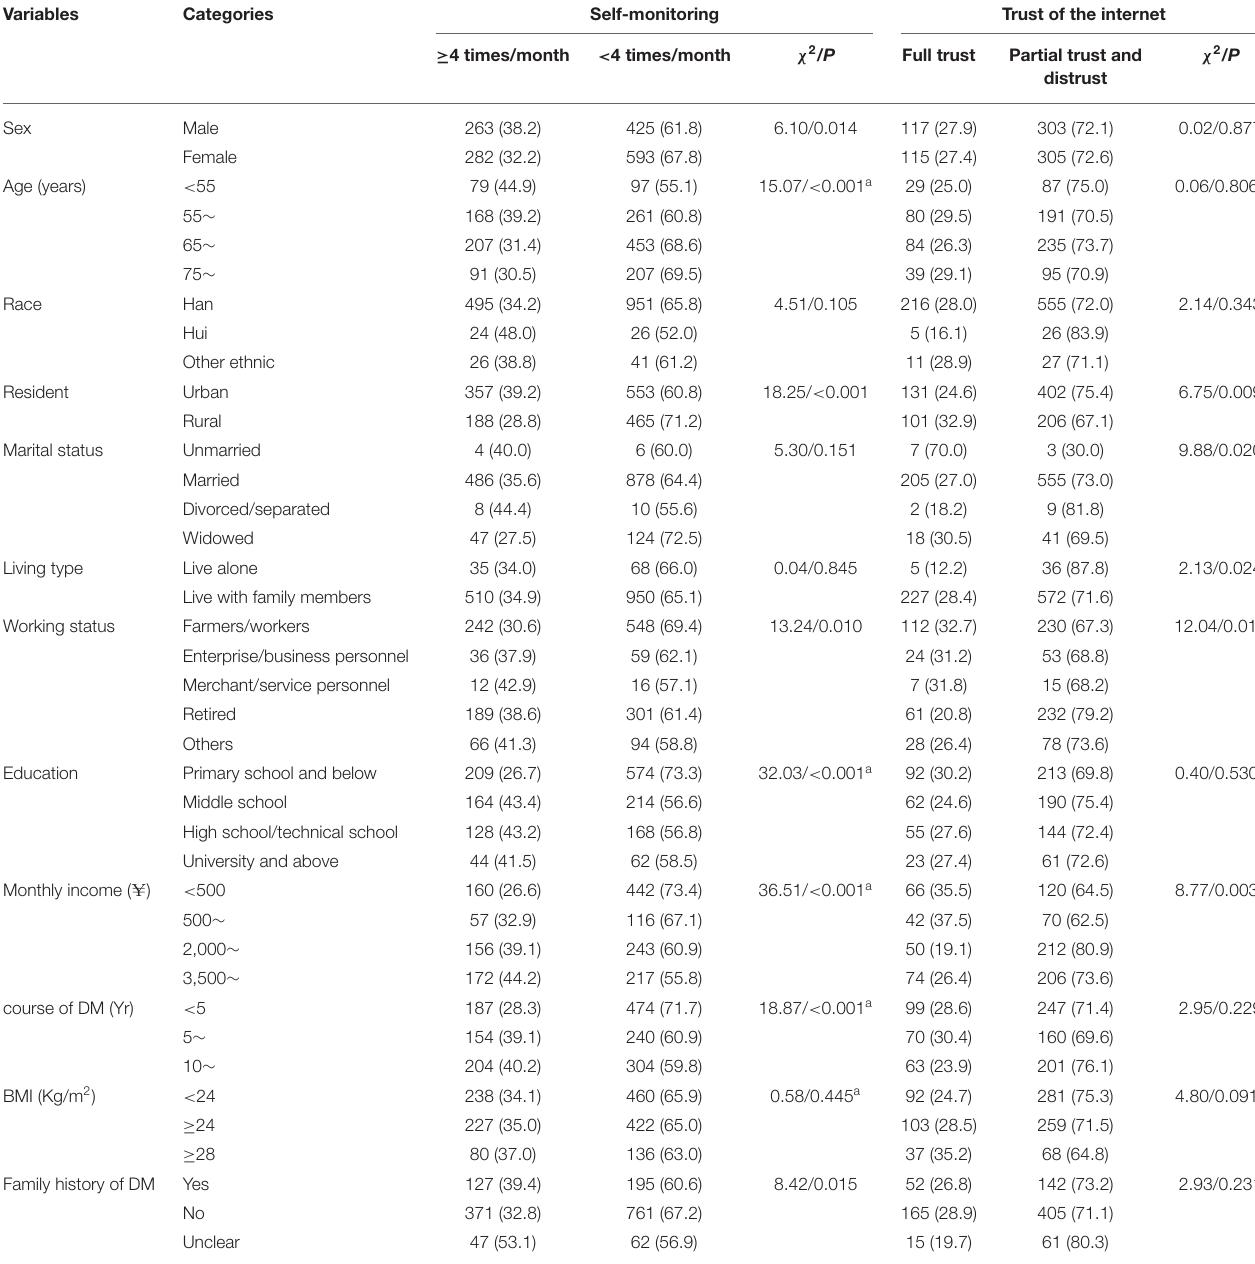
TABLE 4 | Monitoring behavior and internet trust status of the respondents [ n ,